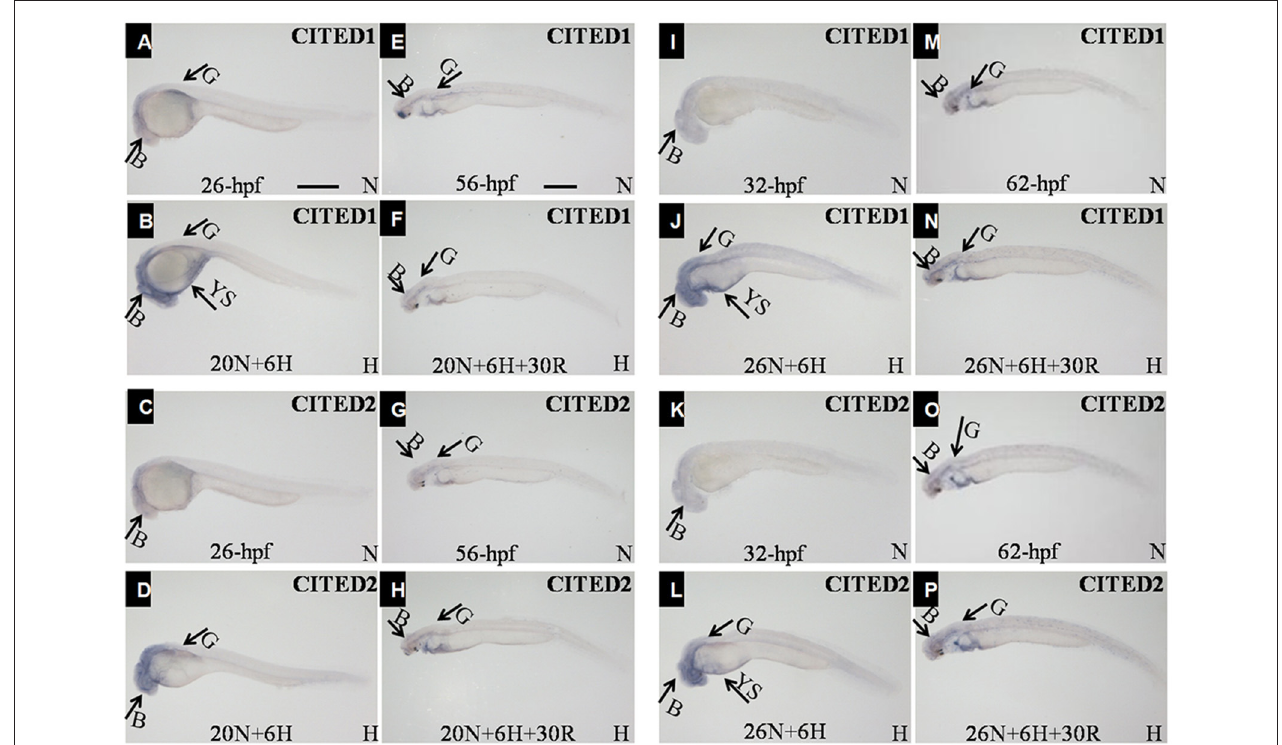
FIGURE 6 | Whole-mount embryo in situ hybridization analysis using the CITED1 (A,B,E,F,I,J,M,N) or -2 (C,D,G,H,K,L,O,P) antisense probe. All embryos are viewed laterally with the head to the left. B, brain; G, gut; TB, tail bud; YS, yolk sac; H, hypoxia (DO = 3.5 ± 0.5 mg/L); N, normoxia (DO = 7.0 ± 0.5 mg/L); Scale bar = 500 µ m. The embryos at (B , D) experienced hypoxia treatment for 6h starting at 20 hpf. The embryos at (F,H) embryos are 30h recovery for the embryos at (B,D) . The embryos at (J,L) experienced hypoxia treatment for 6h starting at 26 hpf. The embryos at (N,P) embryos are 30h recovery for the embryos at (J,L) .